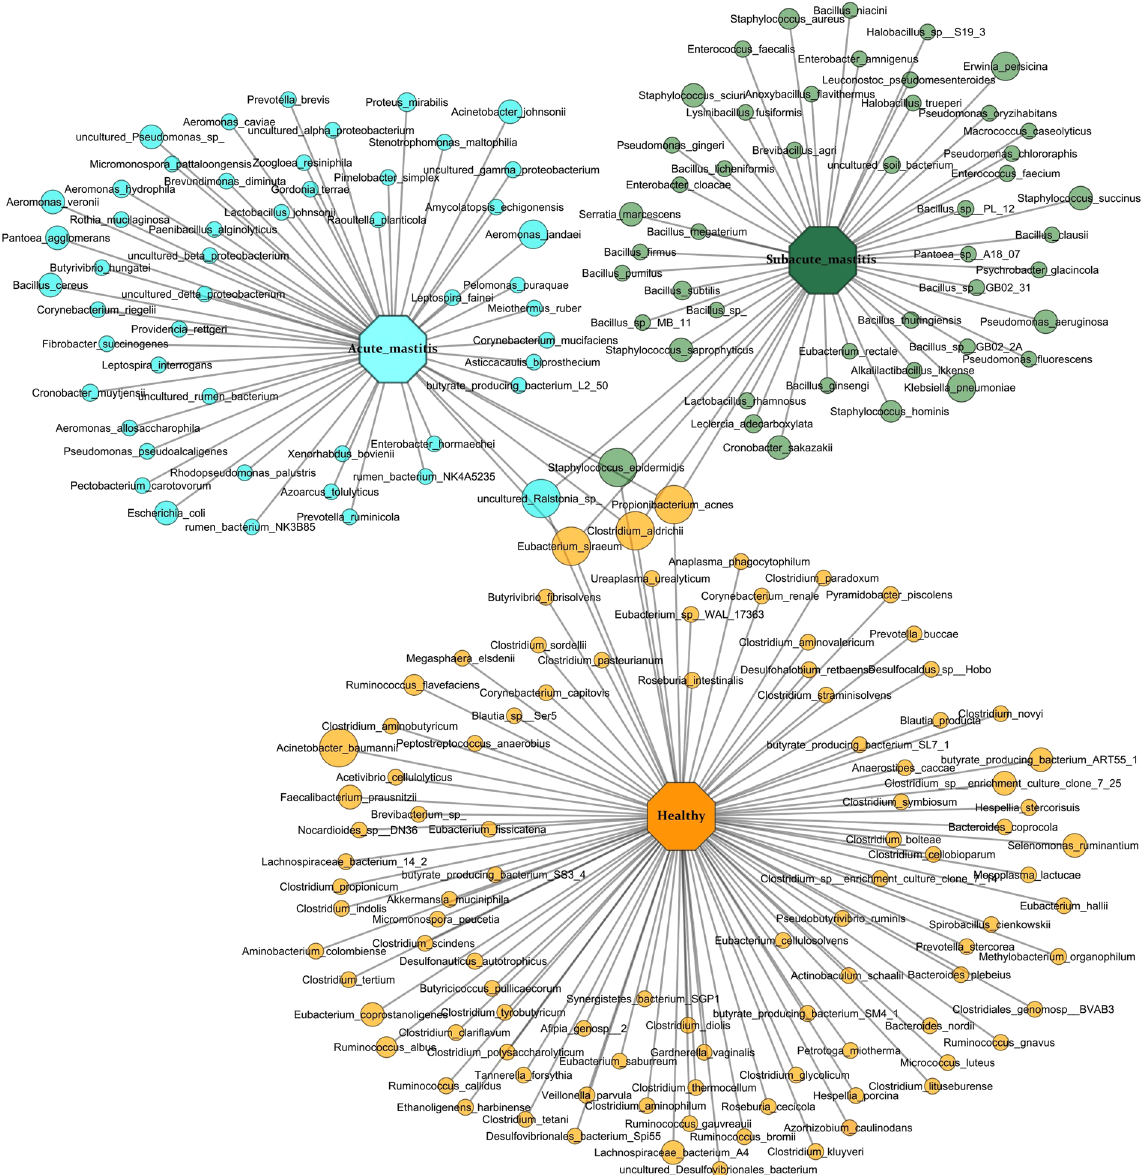
Figure 4. Network of bacterial species enriched in healthy-controls, SAM and AM individuals. Species core in half of the individual tested in each group were compared by LEfSe analysis. Cytoscape was used to construct network of enriched species in healthy-controls, SAM and AM